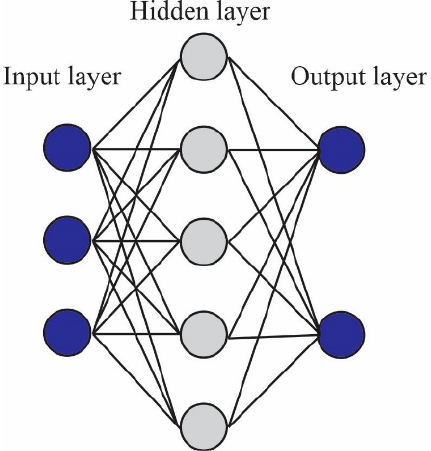
Figure 3. An example of an MLP network with one hidden layer.